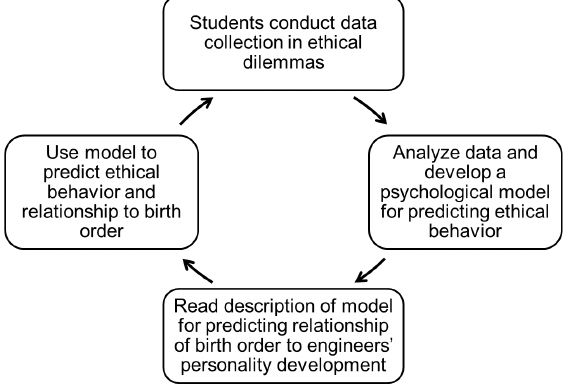
Fig. 1. Modified Kolb’s learning cycle for teaching